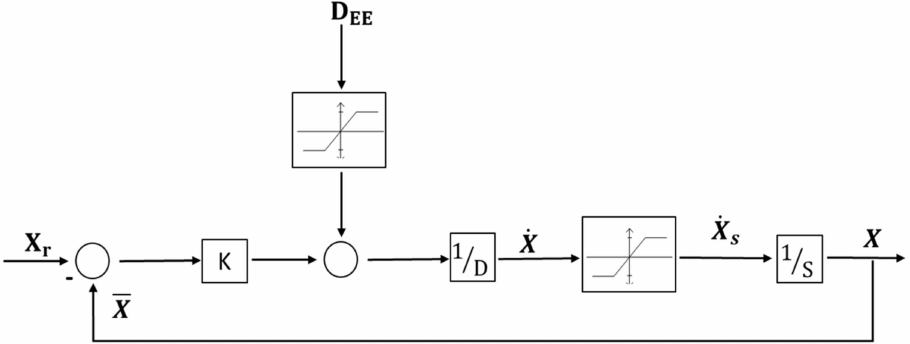
Figure 4. Schematic of the SISO linear system which controls the dynamic evolution of each state variable. The inputs are the reference state vector and the disturbance vector. The saturation for state velocity and disturbance is also